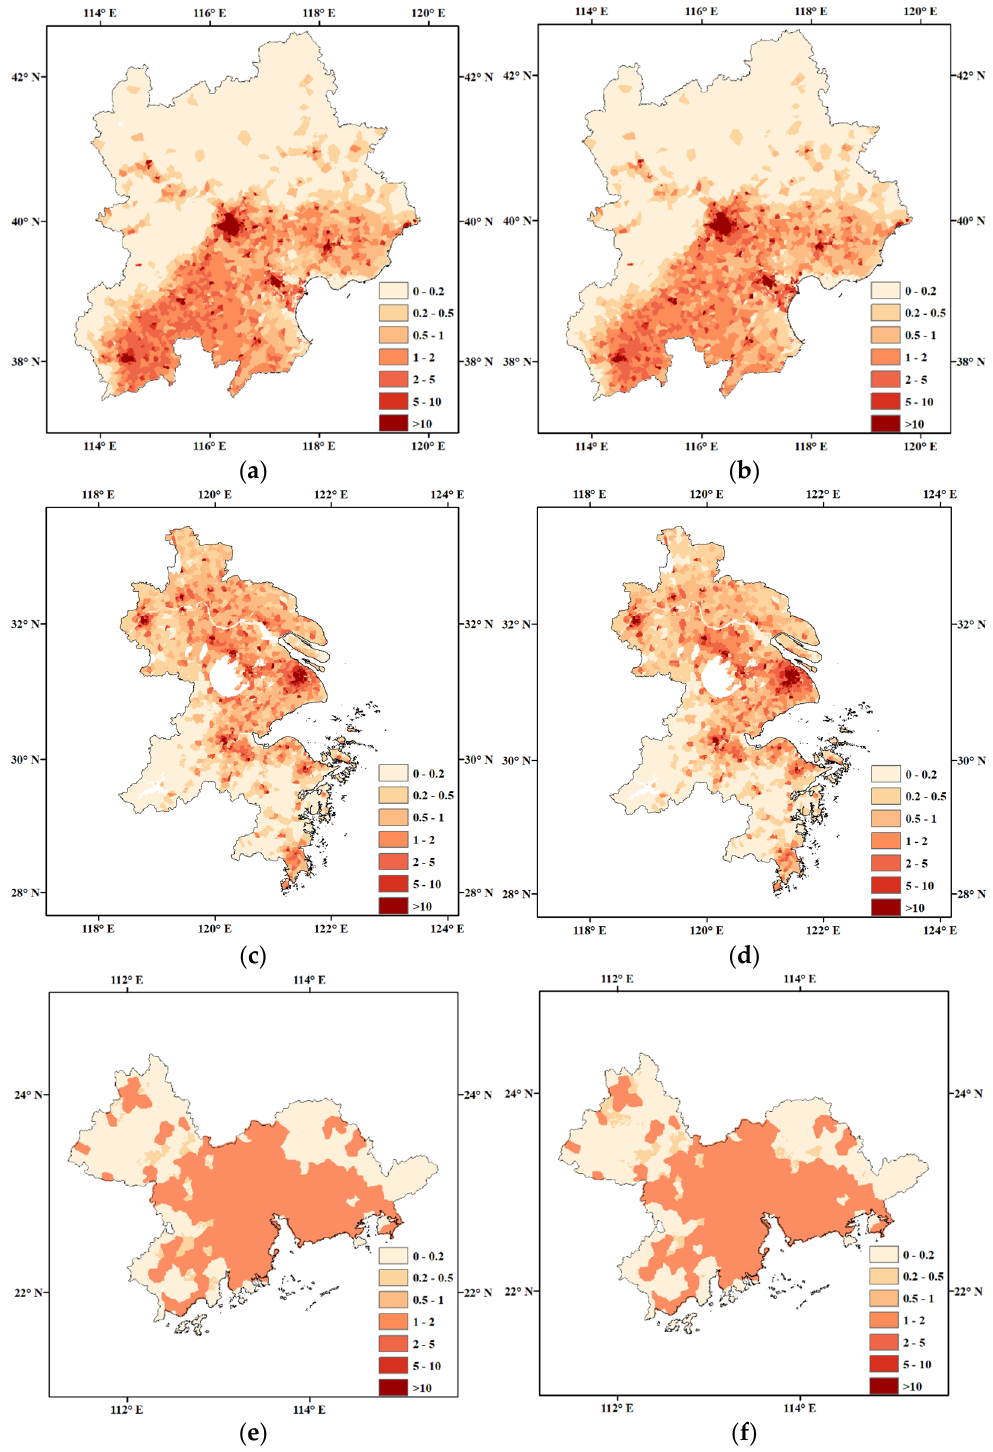
Figure 5. The distribution of PM 2.5 exposure risk measured in persons per km 2 in BTH, YRD, and PRD in 2000 and 2020. ( a ) BTH in 2000. ( b ) BTH in 2020. ( c ) YRD in 2000. ( d ) YRD in 2020. ( e ) PRD in 2000. ( f ) PRD in 2020.